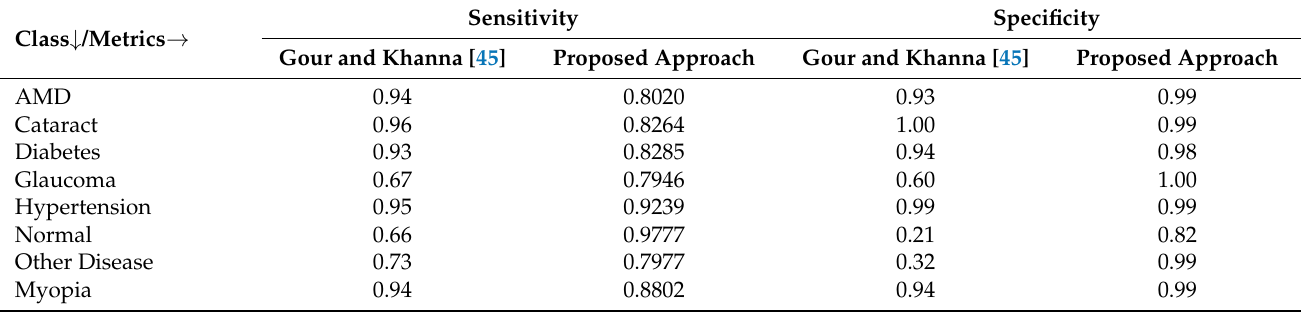
Table 6. Comparison with the model proposed in [45] of the sensitivity and specificity